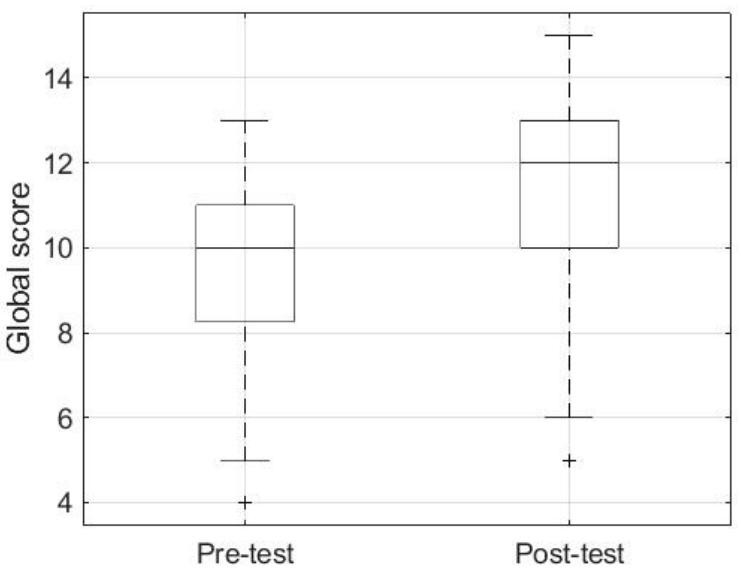
Figure 3. Global STAT score obtained in the pre- and post-test moments. The average (standard deviation) STAT total score was higher in GIS Applied to Natural Sciences than in GIS in the pre-test (9.9 (2.0) vs. 9.3 (1.7)), as well as in the post-test (11.4 (2.2) vs. 11.2 (1.9)), but none of these differences was statistically significant ( p = 0.144 and p = 0.760, respectively). The increase in total score from the pre- to the post-test was more marked in GIS than in GIS Applied to Natural Sciences (2.0 (2.0) vs. 1.5 (2.2)), but this difference was not statistically significant ( p = 0.309, Figure 4).